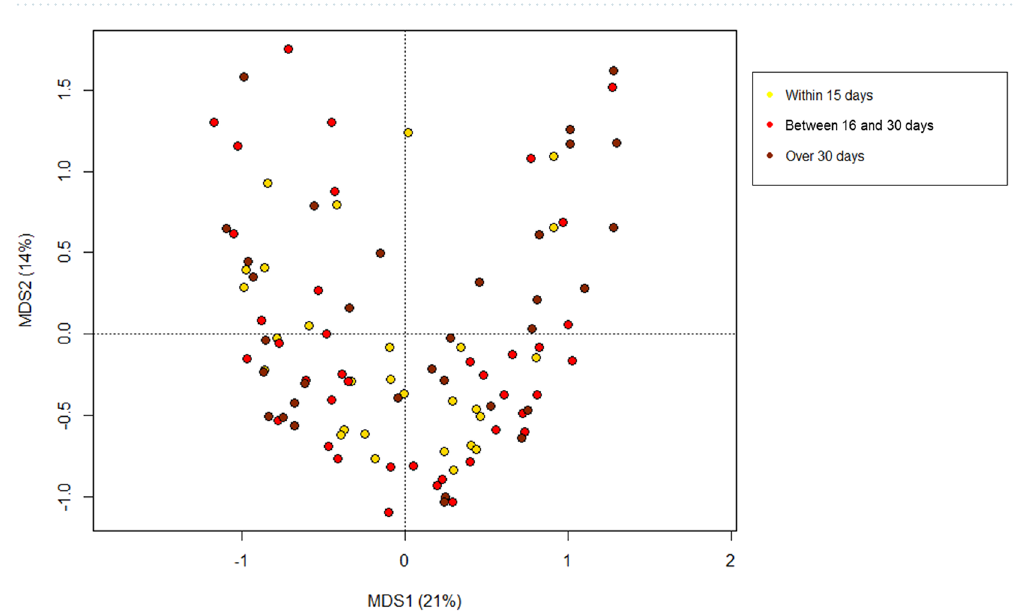
Figure 4. The gut microbiota dysbiosis in SCI patients is stable over time. Principal Coordinates Analysis based on Bray–Curtis distances between the genus-level microbial profiles of SCI patients according to the time interval between injury and fecal sampling (≤ 15 days, between 16 and 30 days, over 30 days). No significant segregation was found (p > 0.05, permutation test with pseudo-F